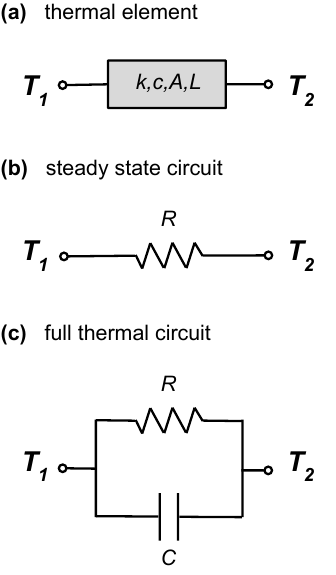
Figure 1. ( a ) Thermal element; ( b ) equivalent thermal circuit for the steady state; ( c ) equivalent thermal circuit for transient response